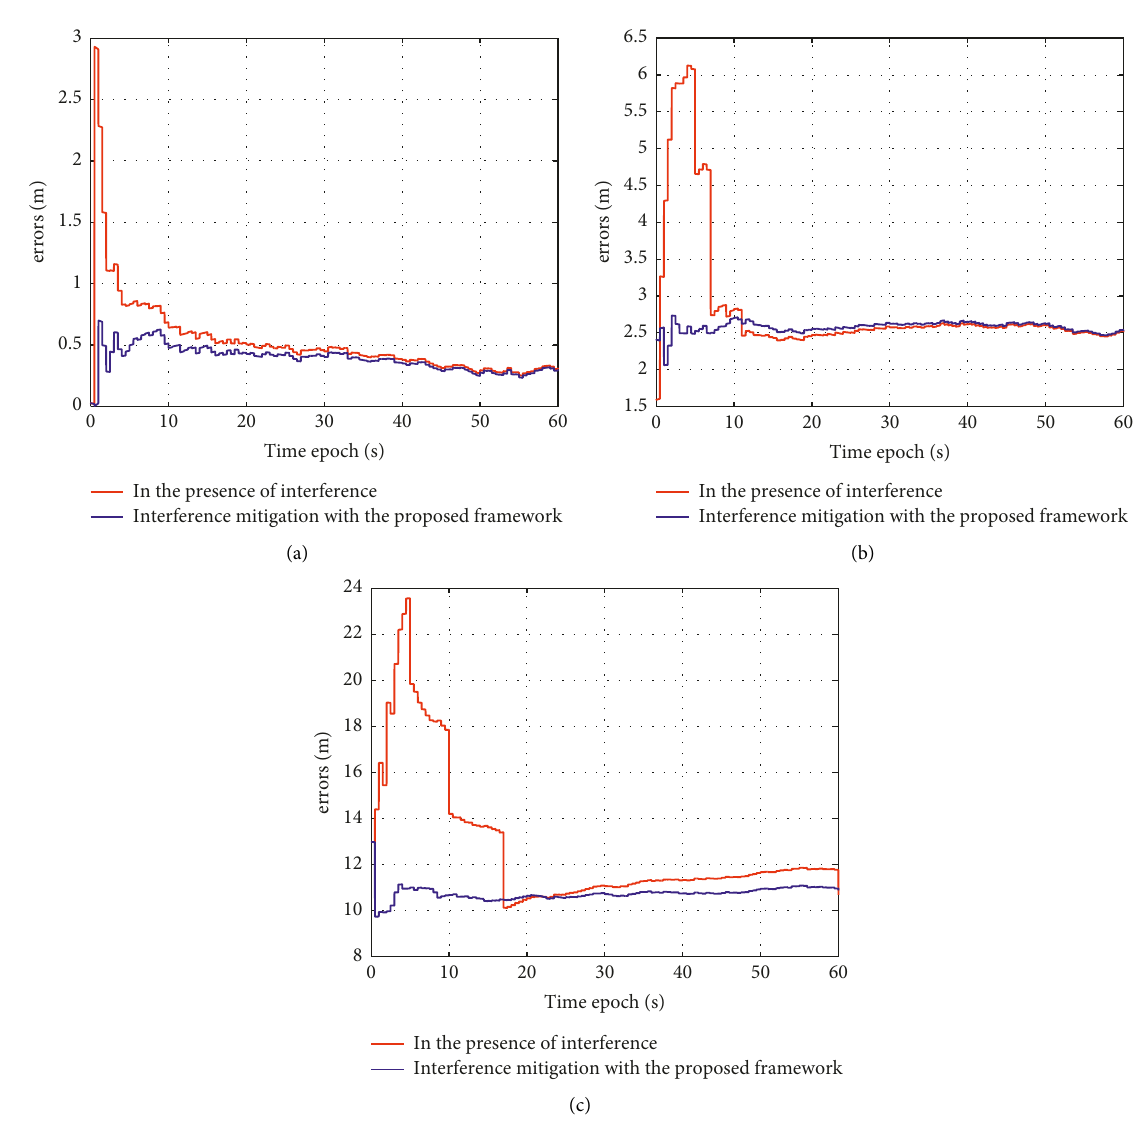
Figure 8: Position errors comparison between using interference mitigation and without mitigation. (a) North position error. (b) East position error. (c) Down position